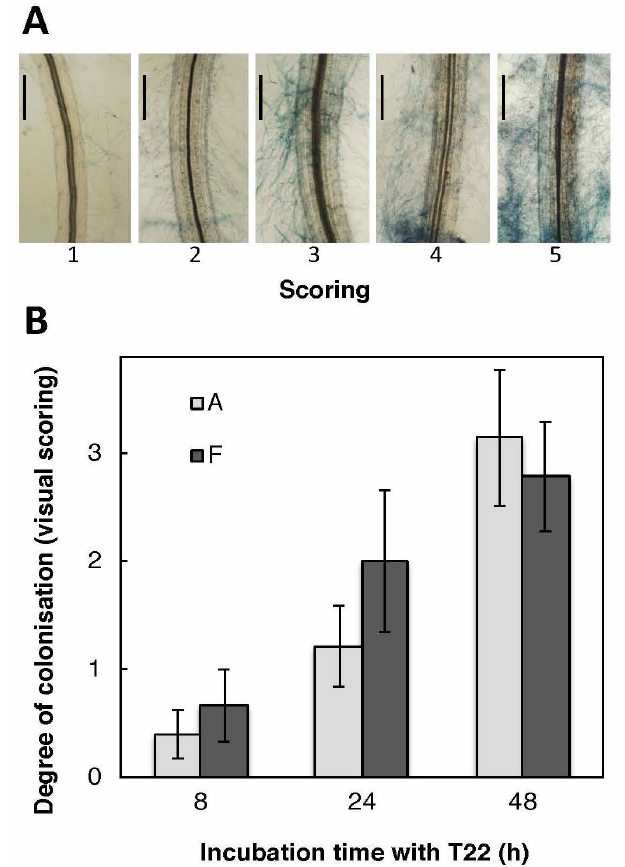
Figure 4. Colonization of sugar beet roots by T22. ( A ) After 48 h of co-cultivation with T22, roots were scored (1–5) for hyphae remaining adhering to the roots after the removal of the agar gel. Score 0 means lack of detectable hyphae on the roots. The bar corresponds to 200 µm. ( B ) The degree of colonization of sterile-grown sugar beet roots of genotypes A (light grey) and F (dark grey) at different time points after infection with T22. Images from lactophenol blue-stained roots were collected from early root hair zone, late root hair zone, and root base from 3–4 roots for each time point and genotype. Average scoring across all three zones ± SE ( n = 6–7 seedlings) is shown. No colonization was observed at root tips.